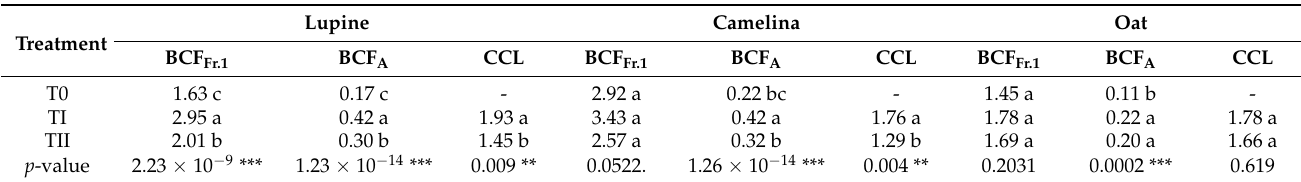
Table 5. Bioconcentration factors (BCF Fr.1 and BCF A ) and coefficient of contamination level (CCL) for plants depending on treatment (mean values).